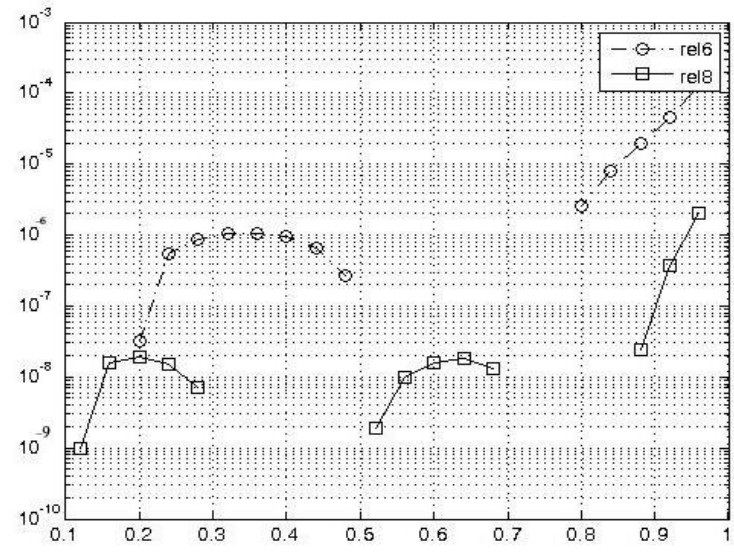
Figure 3. Relative errors of